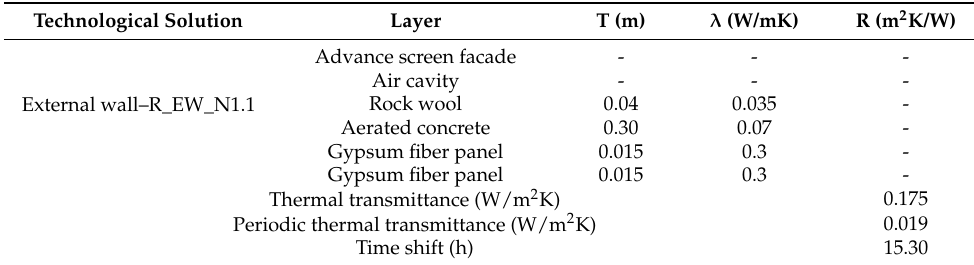
Table A22. Possible redevelopment measure for external wall characterized by the half value of the thermal transmittance of the reference building (R_EW_N1.1).